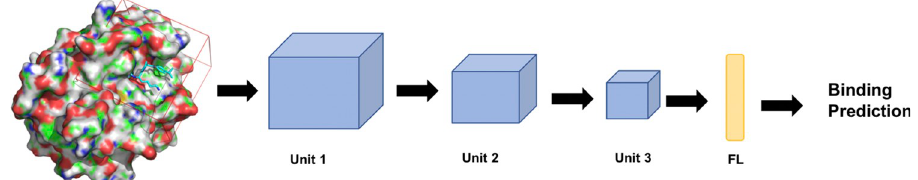
Fig 2. The architecture of the CNN model. Each unit consists of three layers, Pooling, Convolutional and ReLU. The yellow bar labeled FL is the fully connected layer. Further details about the CNN model hyperparameters can be found in reference